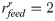
Optimal policies in the absence of a decision cost.(A) Optimal actions a* as a function of current location (left, refuge; right, patch), and current beliefs that a predator is present, βD(P), and that the current habitat quality is good, βQ(G). The discretization of the state space leads to the apparently rough solution. (B) If escape does not lead to safety, then freeze will always be selected in the patch instead. (C–E) The distribution of behaviour shown by the optimal policy depends on whether there is a predator in the environment (black bars) or not (white bars). This includes (C) the proportion of time spent in refuge vs. patch, and (D) the proportion of time spent in different activities. (E) Even though the policy selects activity durations to be as short as possible (τ* = 1 s), contiguous periods of a given action (‘bouts’) may be longer, reflecting successive choices of the same action. The bars show mean bout lengths measured over 100 instantiations of a 15-minute period; error bars indicate ±1 standard error. Environment parameters as above; reward rates rfeedr=2, rfeedp=1, rrest = 0, rtransit = rassess = rfreeze = −0.1, rescape = −1; detection rates δfeed = δtransit = δescape = 0.05, δassess = 0.02, δfreeze = 0.01, δrest = 0; predation punishment rpred = −100; decision cost cd = 0.